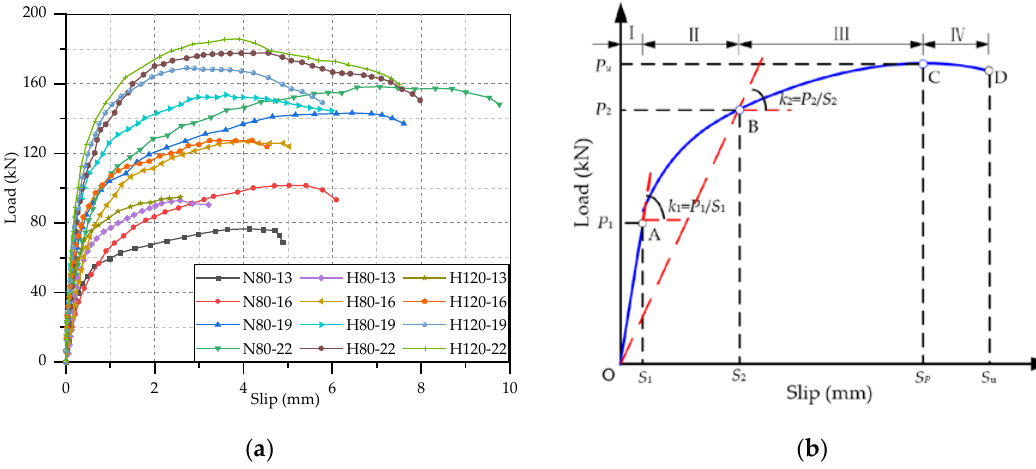
Figure 4. Load-slip curves of specimens: ( a ) test load-slip curves; ( b ) typical load-slip curve.